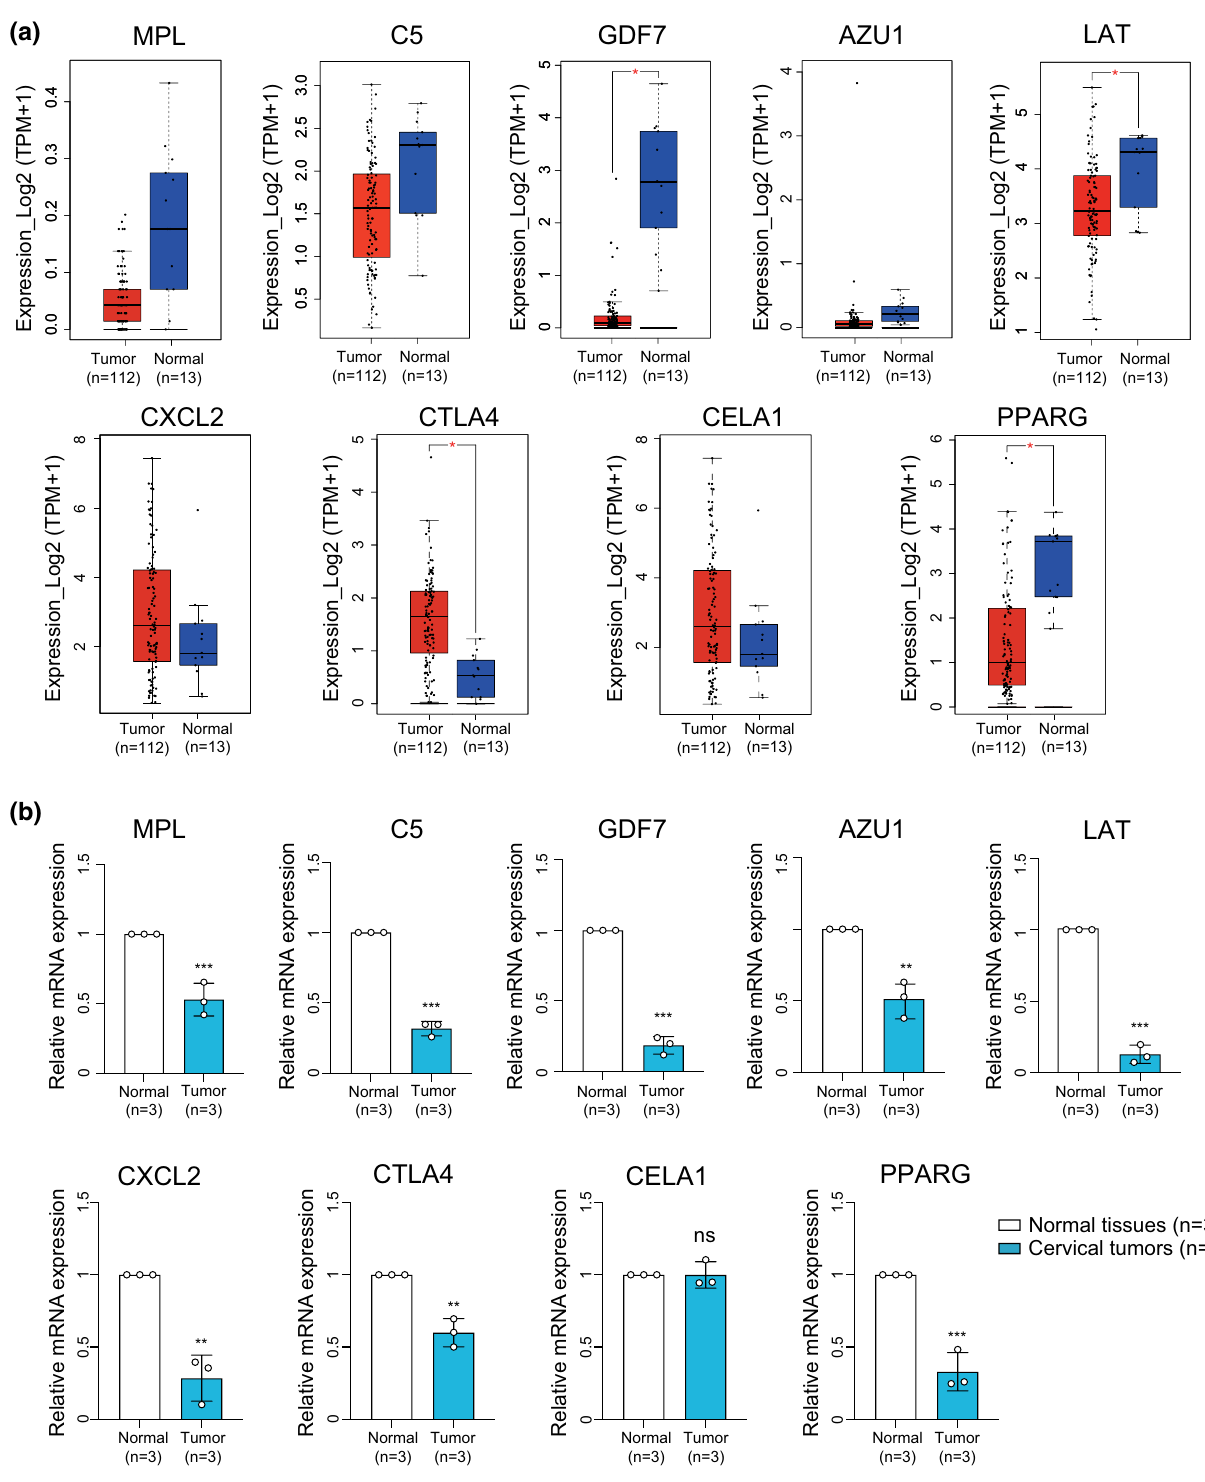
Fig. 8 Validation of the IRRG panel mRNA expression in CC and normal cervical tissues by public database and qPCR. A The mRNA expres- sion levels of nine signature IRRGs identified in PR patient after treatment by RNA-seq were verified in CC tissues (n = 112) and normal cervi- cal tissues (n = 13) in TCGA database. B The mRNA expression levels of nine IRRGs in CC (n = 3) and normal cervical tissues (n = 3) by qPCR. * P < 0.05, ** P < 0.01, *** P <